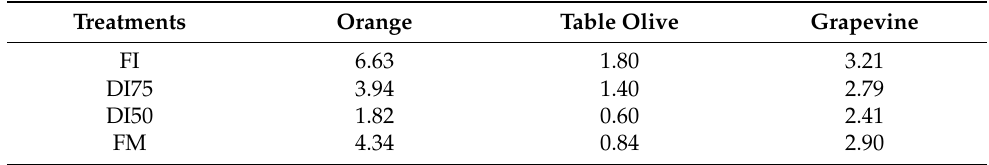
Table 4. Net return (1000 USD · ha − 1 ) of orange, table olive, and grape productions under different strategies. Values represent averages of 2013 and